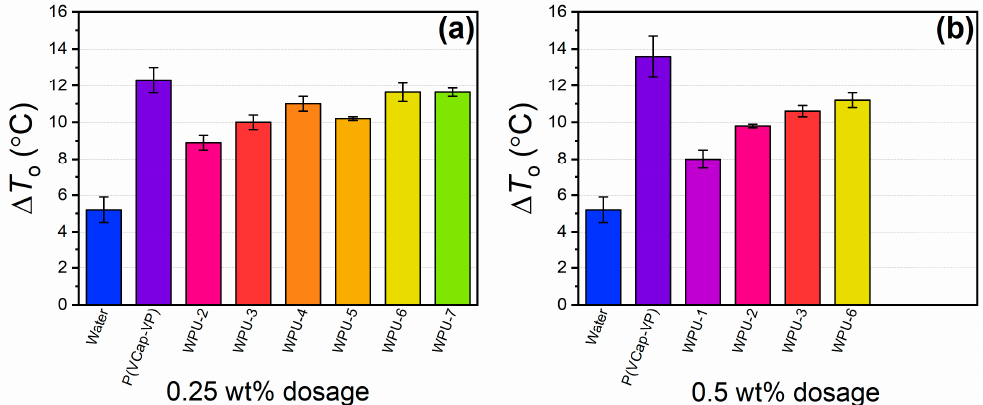
Figure 3. Mean hydrate onset subcooling Δ T o for samples of synthesized polyurethanes at Figure3. Meanhydrateonsetsubcooling ∆ T o forsamplesofsynthesizedpolyurethanesatconcentrations concentrations of 0.25 wt% ( a ) and 0.5 wt% ( b ). Error bars are standard deviations of Δ T o . of 0.25 wt% ( a ) and 0.5 wt% ( b ). Error bars are standard deviations of ∆ T o